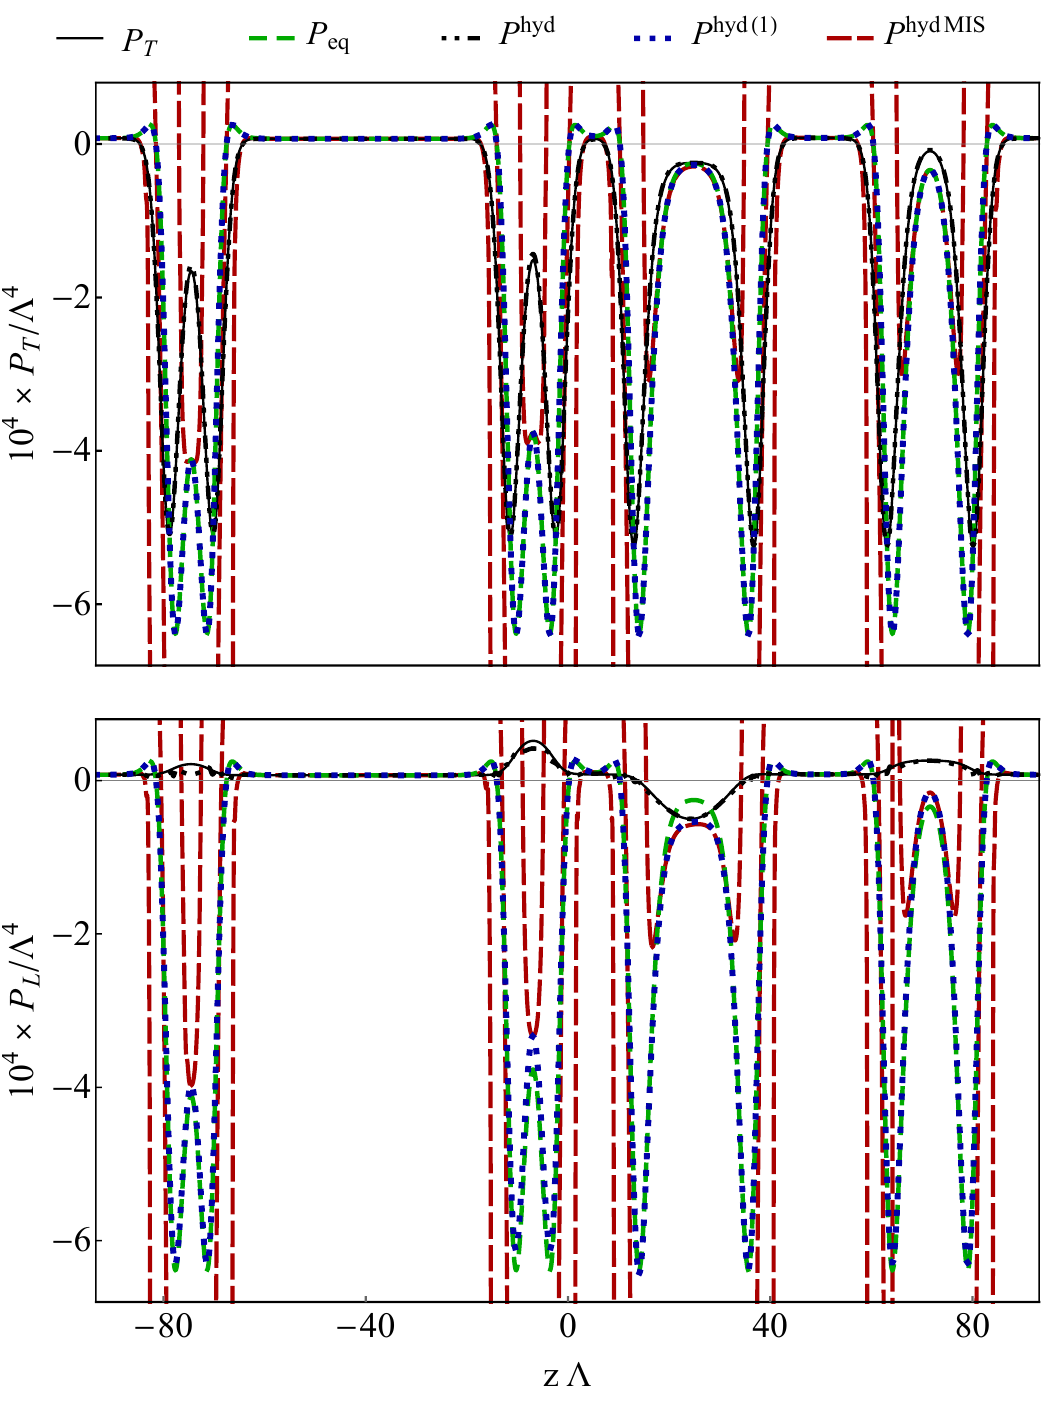
Figure 33 . Snapshots at t (cid:3) = 2000 of the pressures for the evolution shown in (cid:12)gure 4(left). See the caption of (cid:12)gure 32 for details.